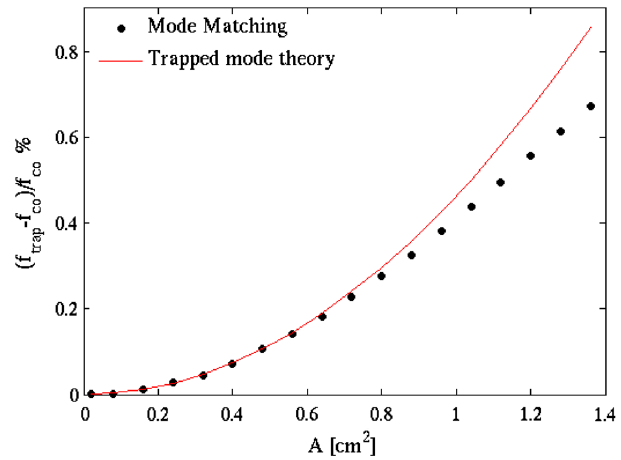
FIG. 16 (color online). Trapped mode frequency estimations with mode matching and theory: t ¼ 2 mm, b ¼ 5 cm, σ ¼ 10 − 8 S=m . A spans from 0 . 02 cm 2 to 1 . 36 cm 2 . P ¼ 5 , S ¼ 5